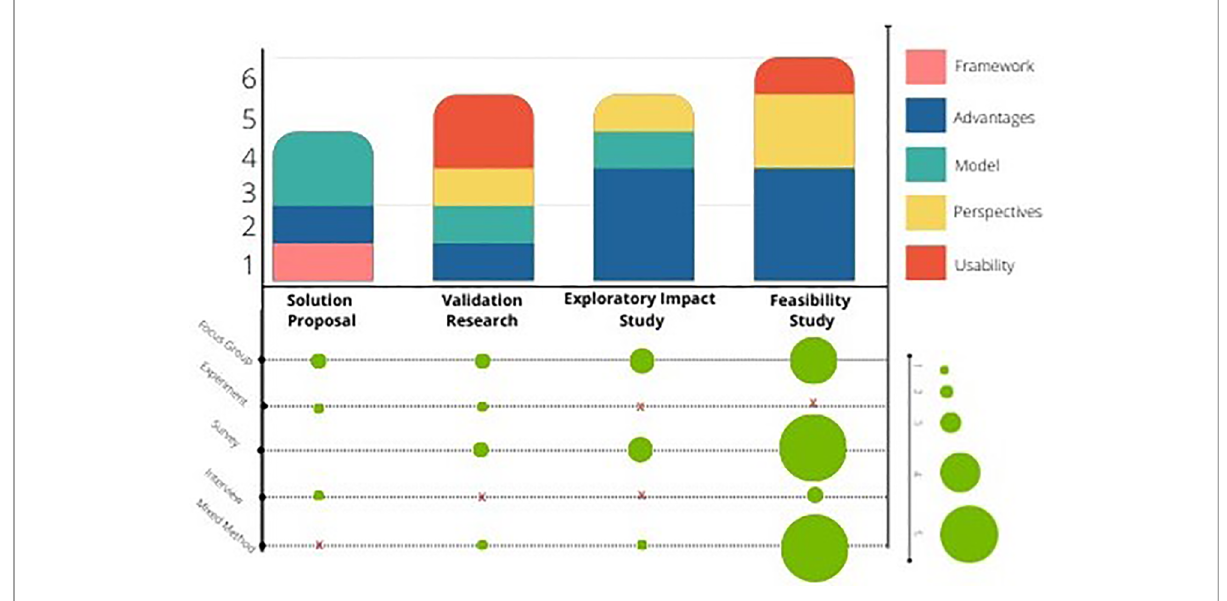
FIGURE 4 Association between research types, types of contributions, and empirical